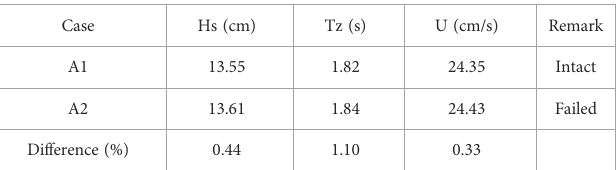
TABLE 2 Input irregular wave and current conditions in model test